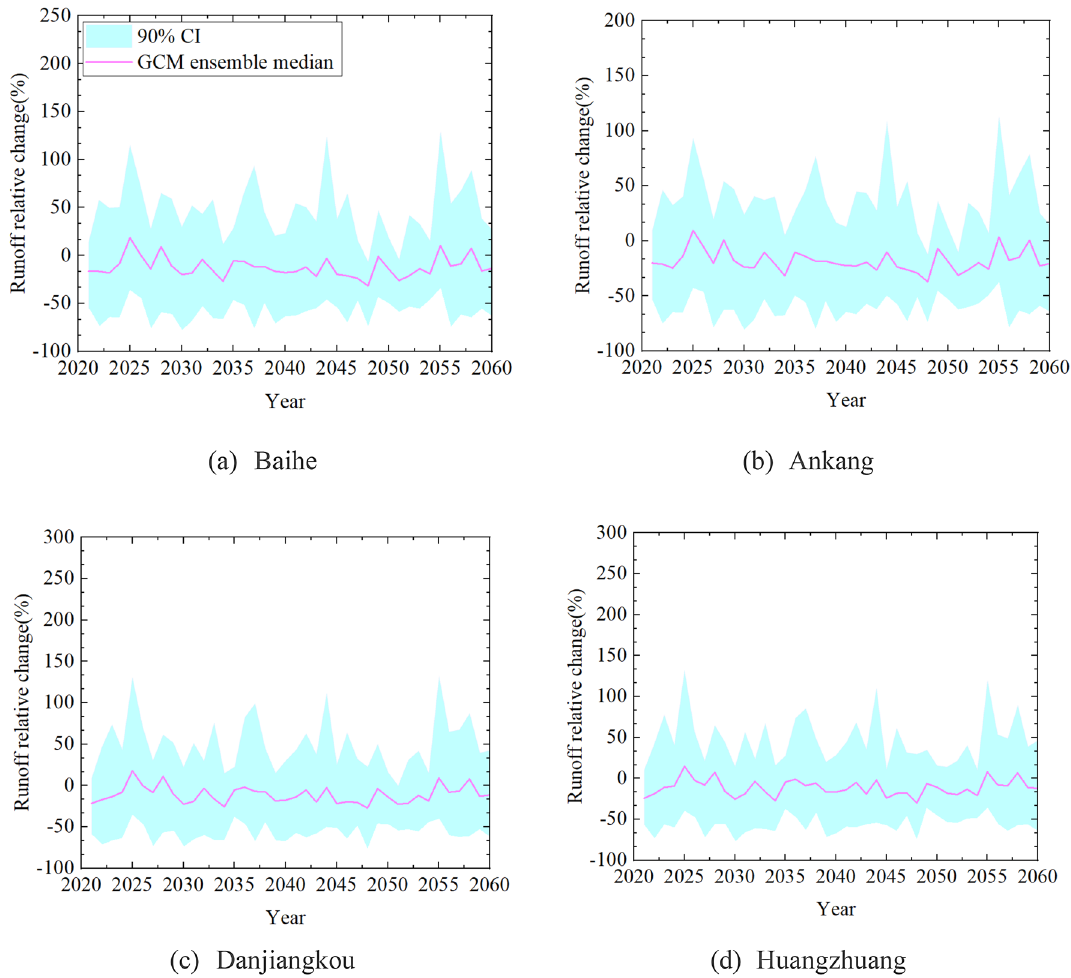
Figure 10. Uncertainty range of future runoff projection at four hydrological stations in the Han